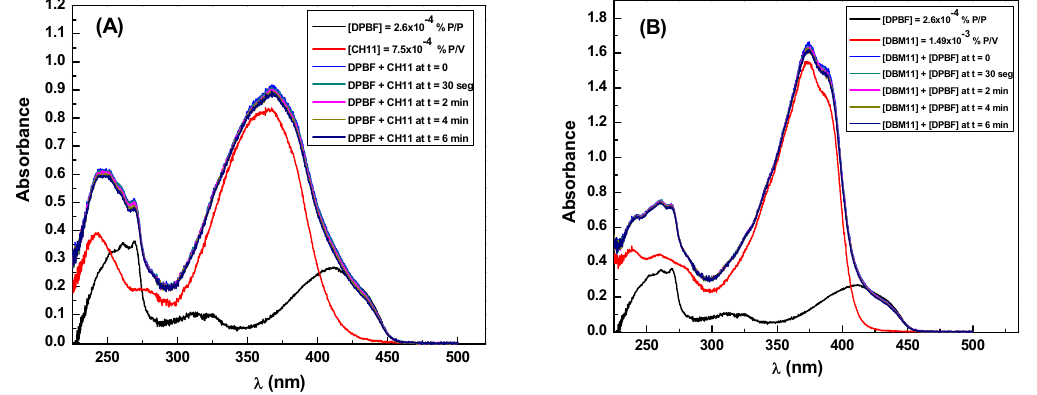
Figure 9. Spectra of CH11 ( A ) and DBM11 ( B ) mixed with difenilisobenzofurane (DPBF).